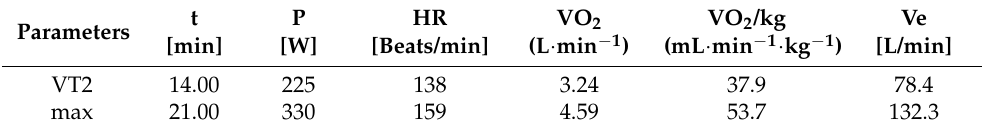
Table 2. Exercise (threshold and maximum) levels of selected physiological